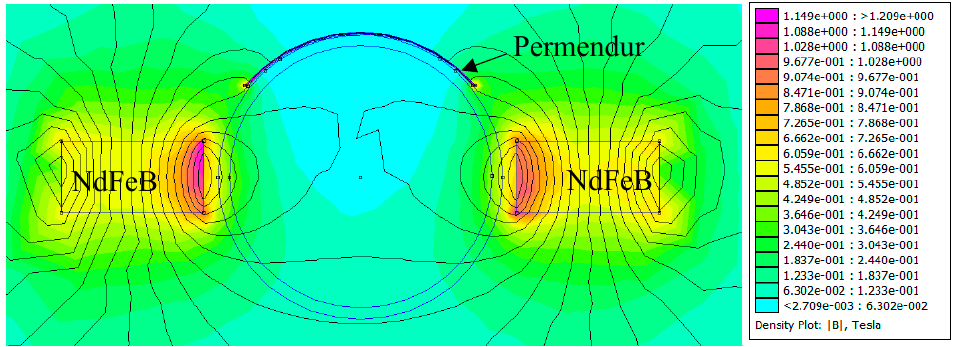
Figure 9. Penetration of the magnetic field created by two permanent NdFeB magnets in the permendur strip. Maximum magnetic field obtained in permendur strip: 1.3 T.